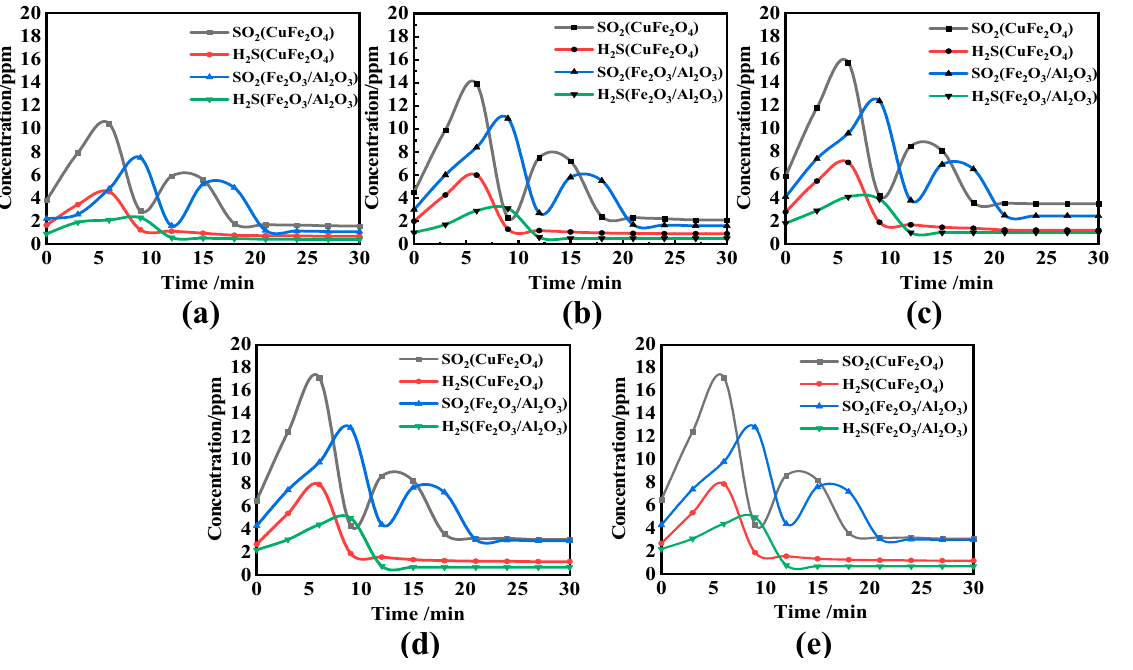
Figure 6. The variation trend of SO 2 and H 2 S with time in the process of CLC at ( a ) 650 °C, ( b ) 700 °C, ( c ) 750 °C, ( d ) 800 °C and ( e ) 850 °C.